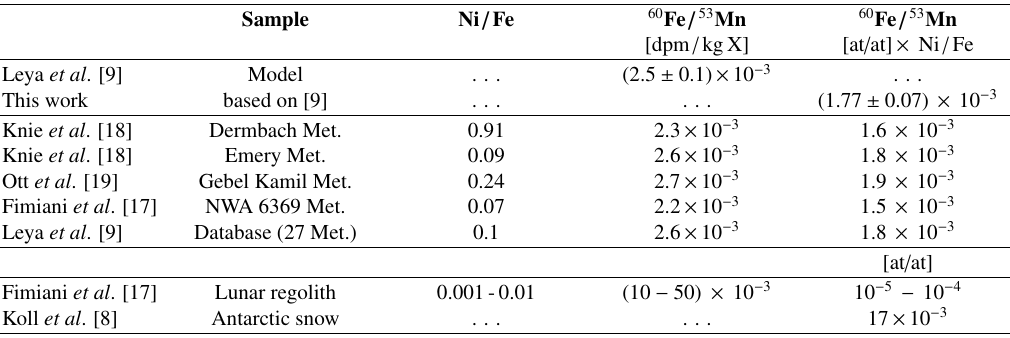
Table 1: Summary of 60 Fe / 53 Mn ratios from the theoretical model, the meteorite database and the samples lunar regolith as well as Antarctic snow. Depending on the origin of the analyzed sample, one has to compare any measured data with the first or the second 60 Fe / 53 Mn ratio for extraterrestrial or terrestrial samples, respectively. The unit dpm / kgX refers to the specific activity ratio with X being the respective target element for the production of 60 Fe or 53 Mn. In particular for lunar regolith, the measured atomic ratio is misleading because of the low intrinsic Ni / Fe. 60 Fe / 53 Mn ratios around 10 − 3 indicate cosmogenic production, whereas higher ratios indicate a surplus of interstellar 60 Fe.